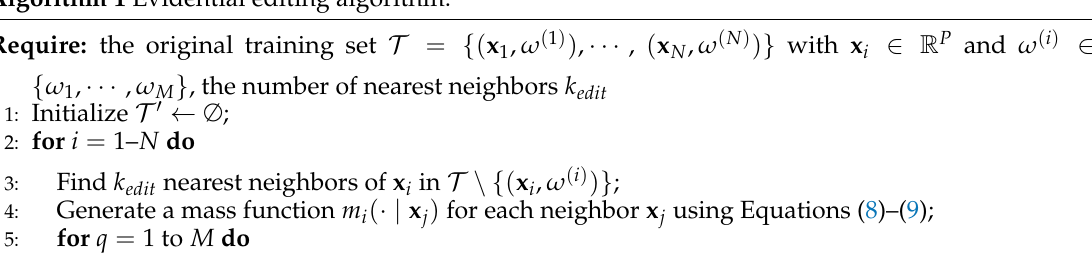
Algorithm 1 Evidential editing